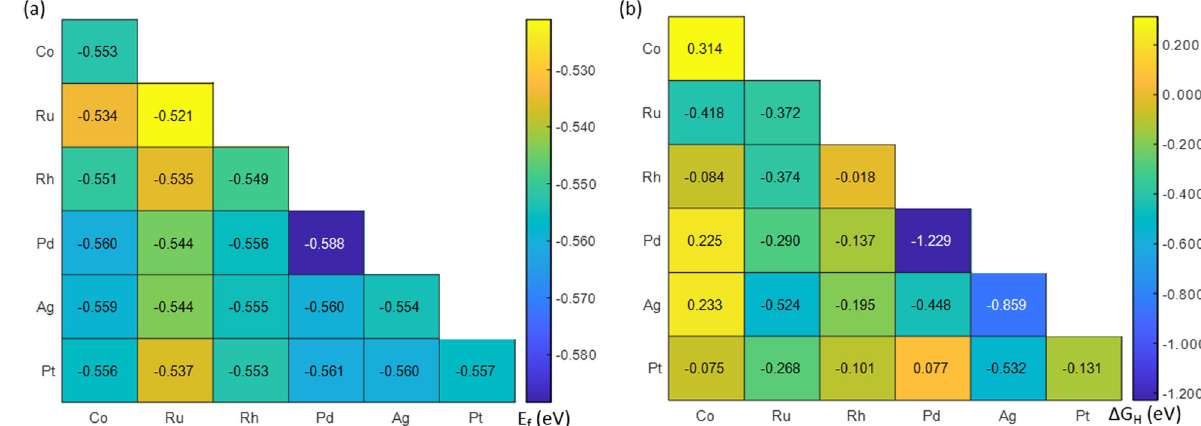
Fig. 9 Formation energy (and Gibbs free energy of hydrogen adsorption for the studied 21TM1-TM2@CdS structures. Formation energy, Ef ( a ), and Gibbs free energy, Δ G H ( b ). The abscissa andordinate represent TM1 and TM2 of the TM1-TM2@CdS surfaces. The color responds to the value of the studied property for each surface, as indicated in the color scale. Data are available in Zenodo.